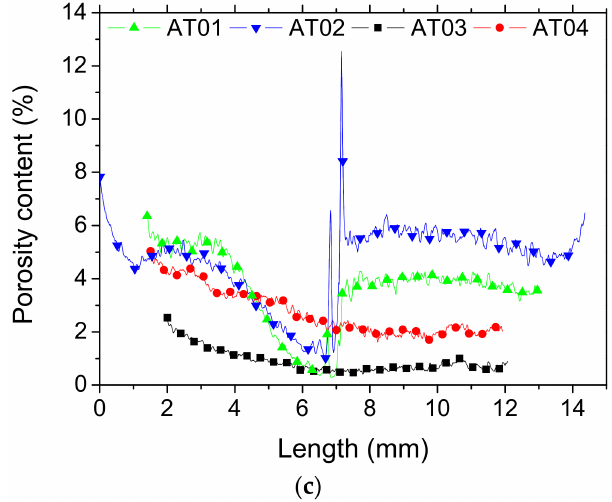
Figure 6. Porosity profiles in: ( a ) depth Z, ( b ) width, and ( c ) along the largest dimension (Y) as a function of the interface orientation and the number of intertwining droplets.